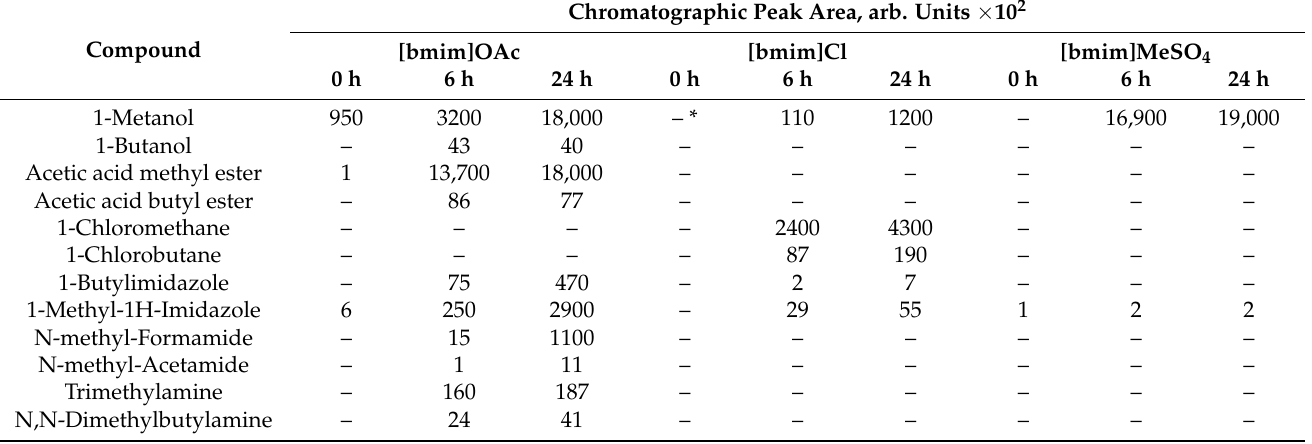
Table 1. Results of HS-GC-MS analysis of volatile and semi-volatile degradation products in IL samples before (0-h) and after 6- and 24-h thermal treatment at 150 °C.